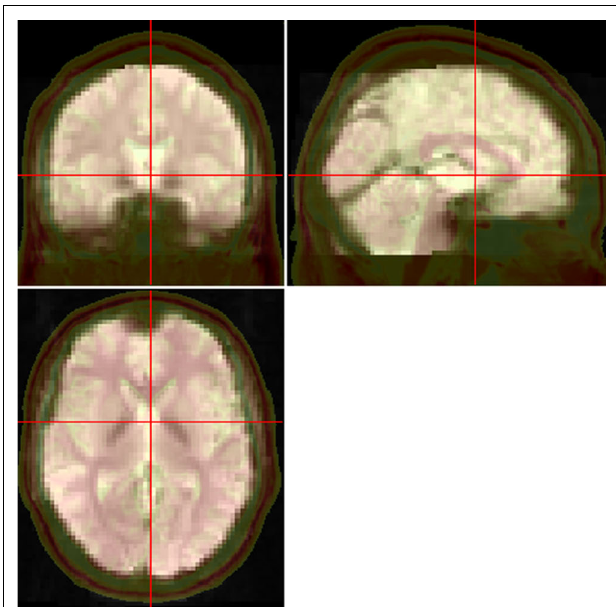
FIGURE 2 | Pictures for checking normalization. The normalized functional image was overlaid on a high resolution 3D anatomical image (the opaque one with skull. From “Colin Holmes,” http://imaging.mrc-cbu.cam.ac.uk/ downloads/Colin/, also distributed with MRIcroN as ch2) in the MNI space. Users can easily check the accuracy of spatial normalization by visual